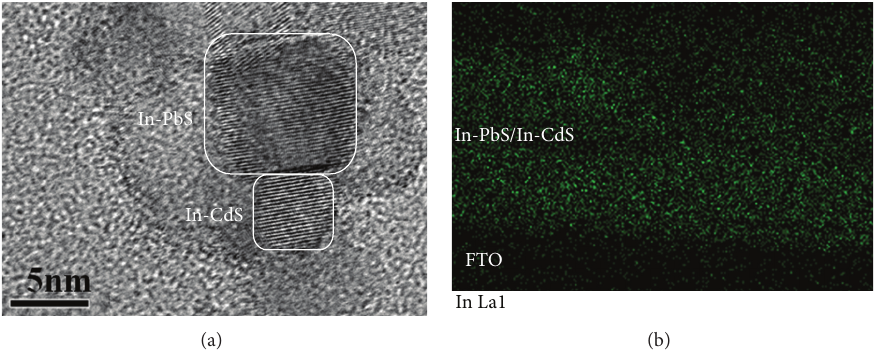
Figure 3: (a) The HRTEM of In-PbS/In-CdS and (b) the EDX mapping of the cross section In-PbS/In-CdS QD sensitized TiO 2 film.